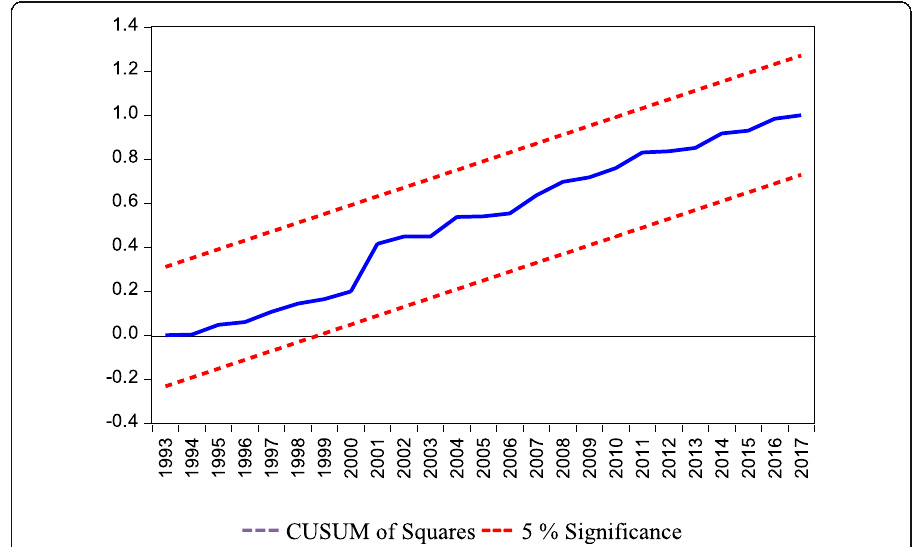
Fig. 2 Plot of Cumulative Sum of The Square of Recursive Residuals (CUSUMQ) at 5% level of